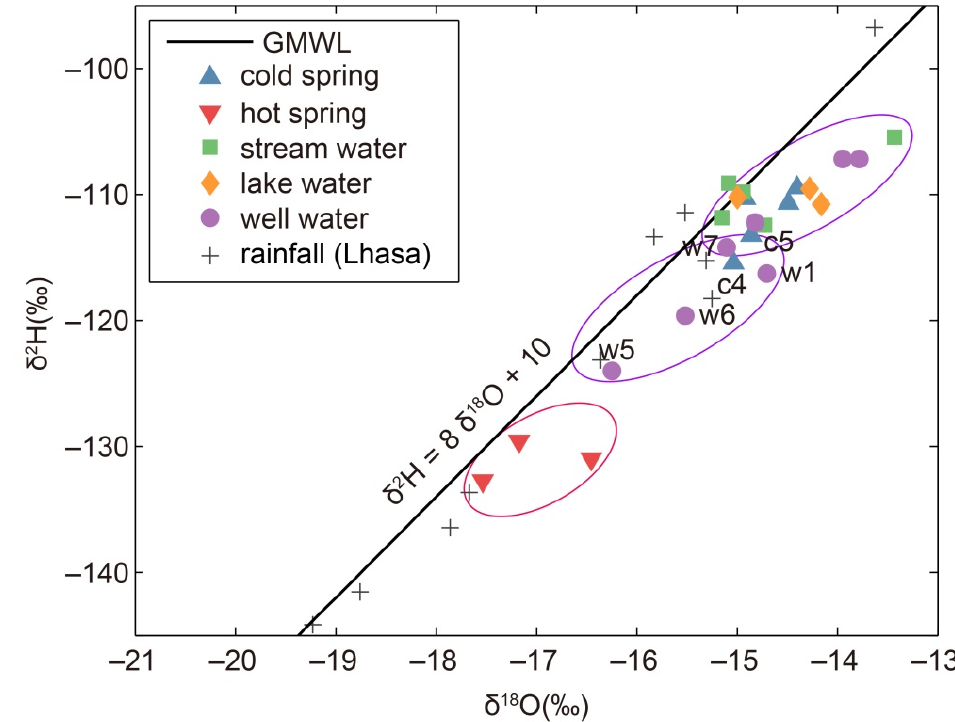
Figure 6. δ 18 O vs. δ 2 H values of the 23 water samples and their correlations with GMWL. The data of Lhasa rainfall (1986~1992) available in this study are generated under the IAEA Water Resources Programme’s monitoring networks: the Global Network of Isotopes in Precipitation (GNIP).